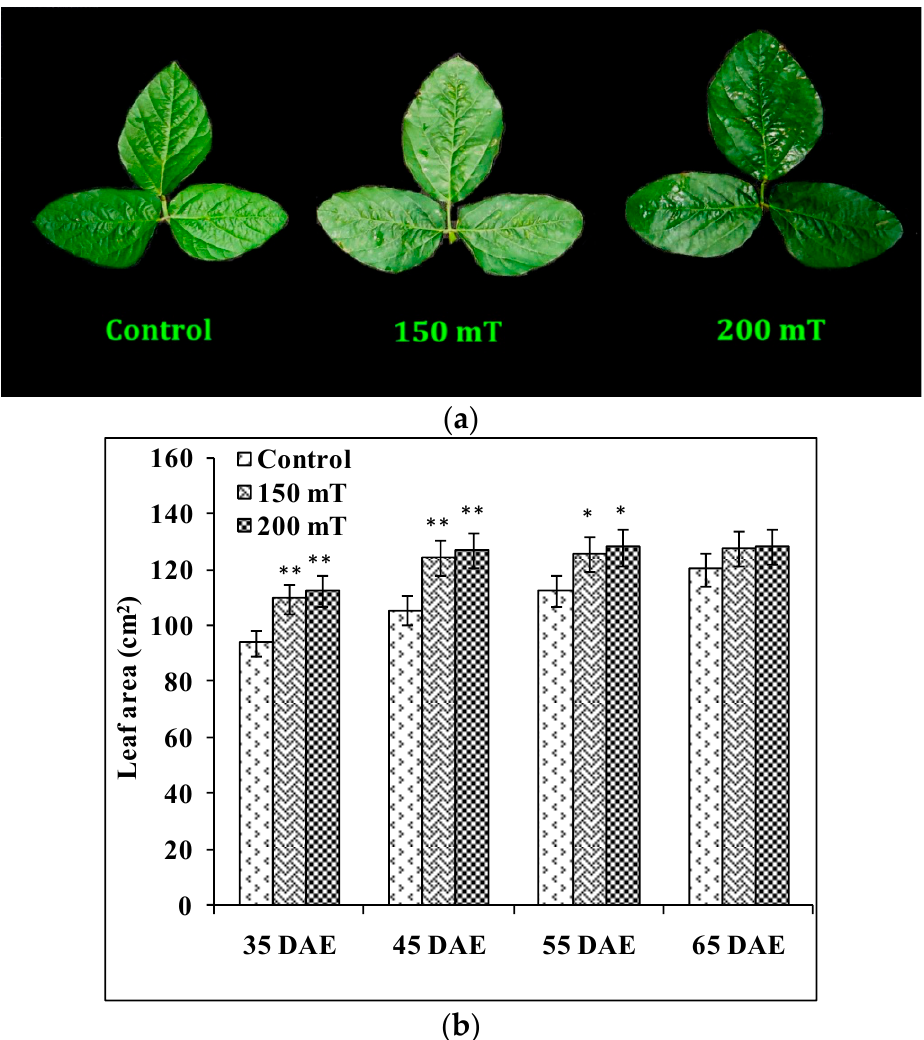
Figure 4. ( a ) Photograph showing the representative effect of pre-sowing magnetic field treatment of soybean seeds on leaf area at 45 DAE. ( b ) Effect of pre-germination magnetic field treatment of soybean seeds on leaf area. ** and * indicate significance at p < 0.01 and 0.05, respectively, compared to